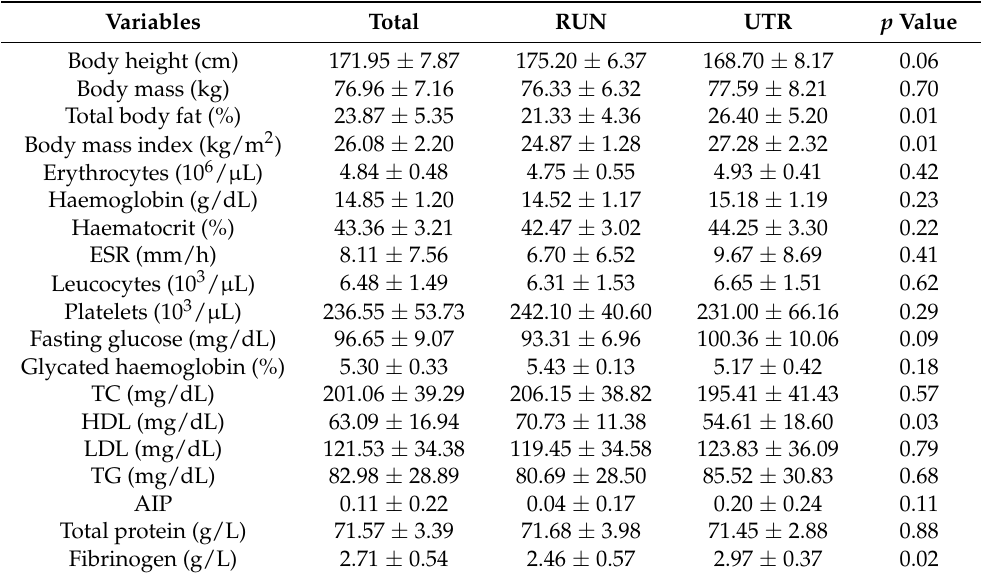
Table 1. Somatic characteristics and medical qualification of study participants (mean ± SD).